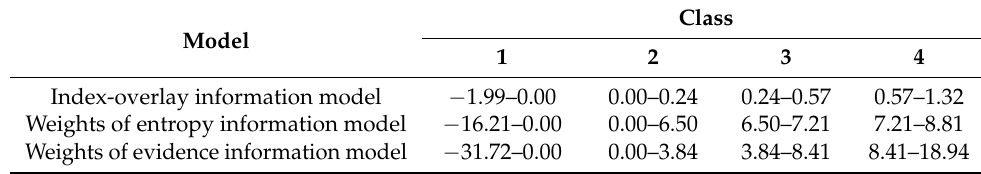
Table 6. Threshold of model classification values.